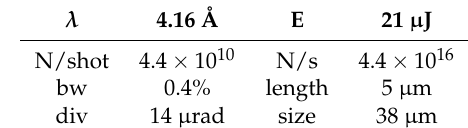
Table 6. Radiation characteristics of the regenerative amplifier. The repetition rate of the source is 1 MHz. Symbols are explained in Table 3 .